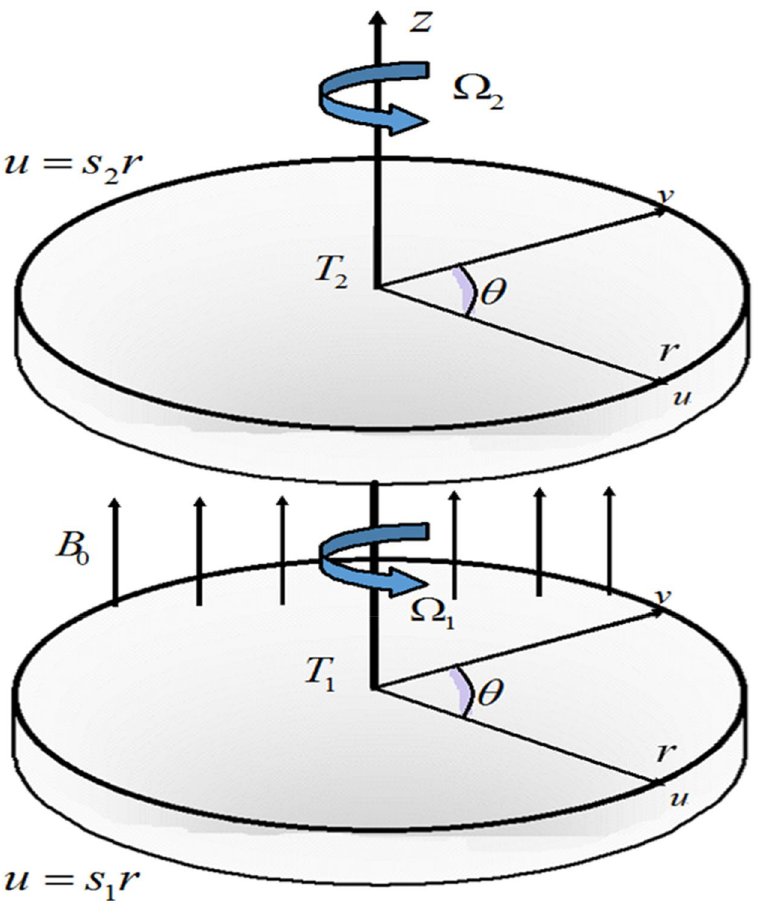
Figure 1. Geometry of the